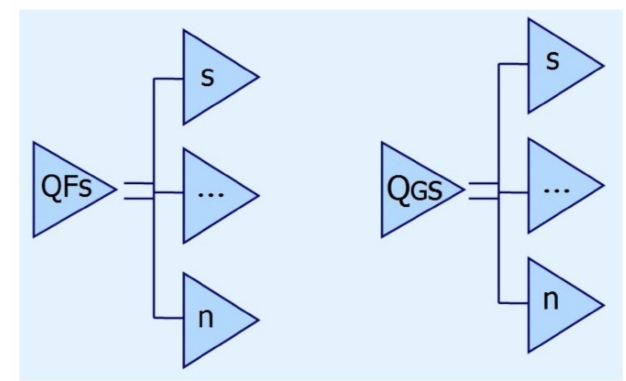
Figure 12. Object representation of generalized forces.